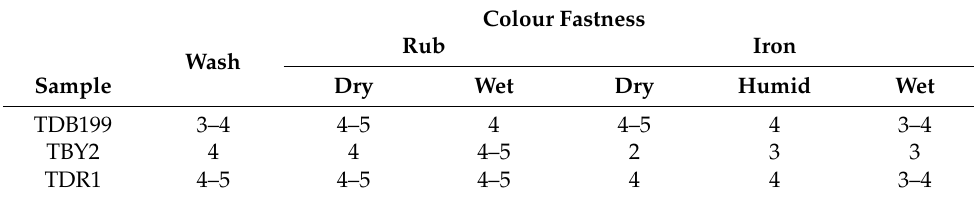
Table 4. Colour fastness values by greyscale index.